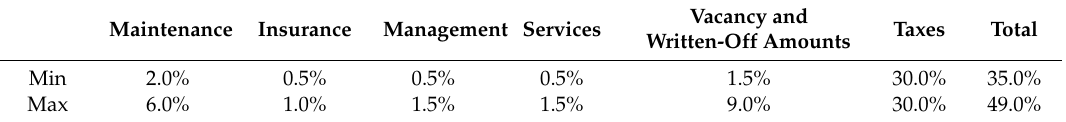
Table 2. Scheme for the Management Owner’s Expenditures